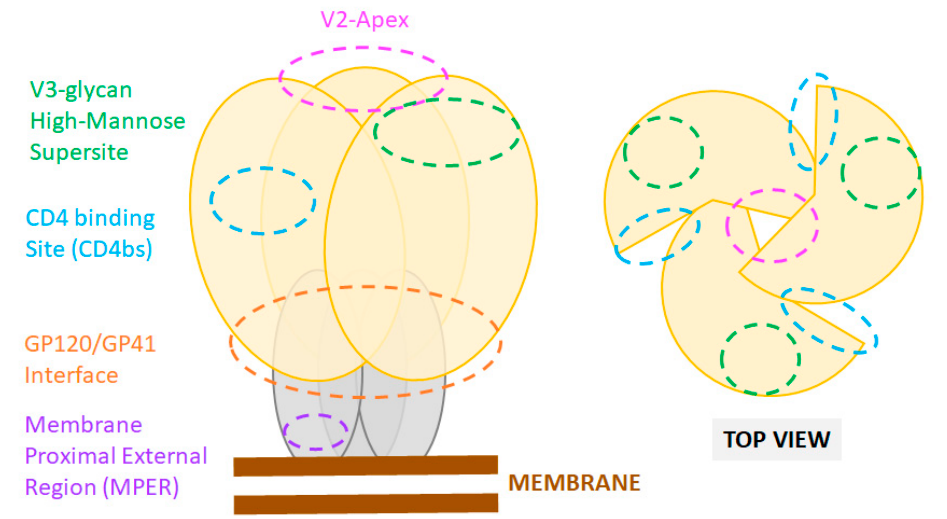
Figure 1. Sites of vulnerability on the HIV-1 Env trimer. Cartoon representation of the Env trimer composed of three gp120 (yellow) and three gp41 subunits (grey) as displayed at the viral mem- brane (brown). Epitope locations of common bnAbs are shown as color-coded dashed line circles. Footprints of bnAbs on an actual X-ray crystal structure of the HIV Env are also presented in recent reviews [88].